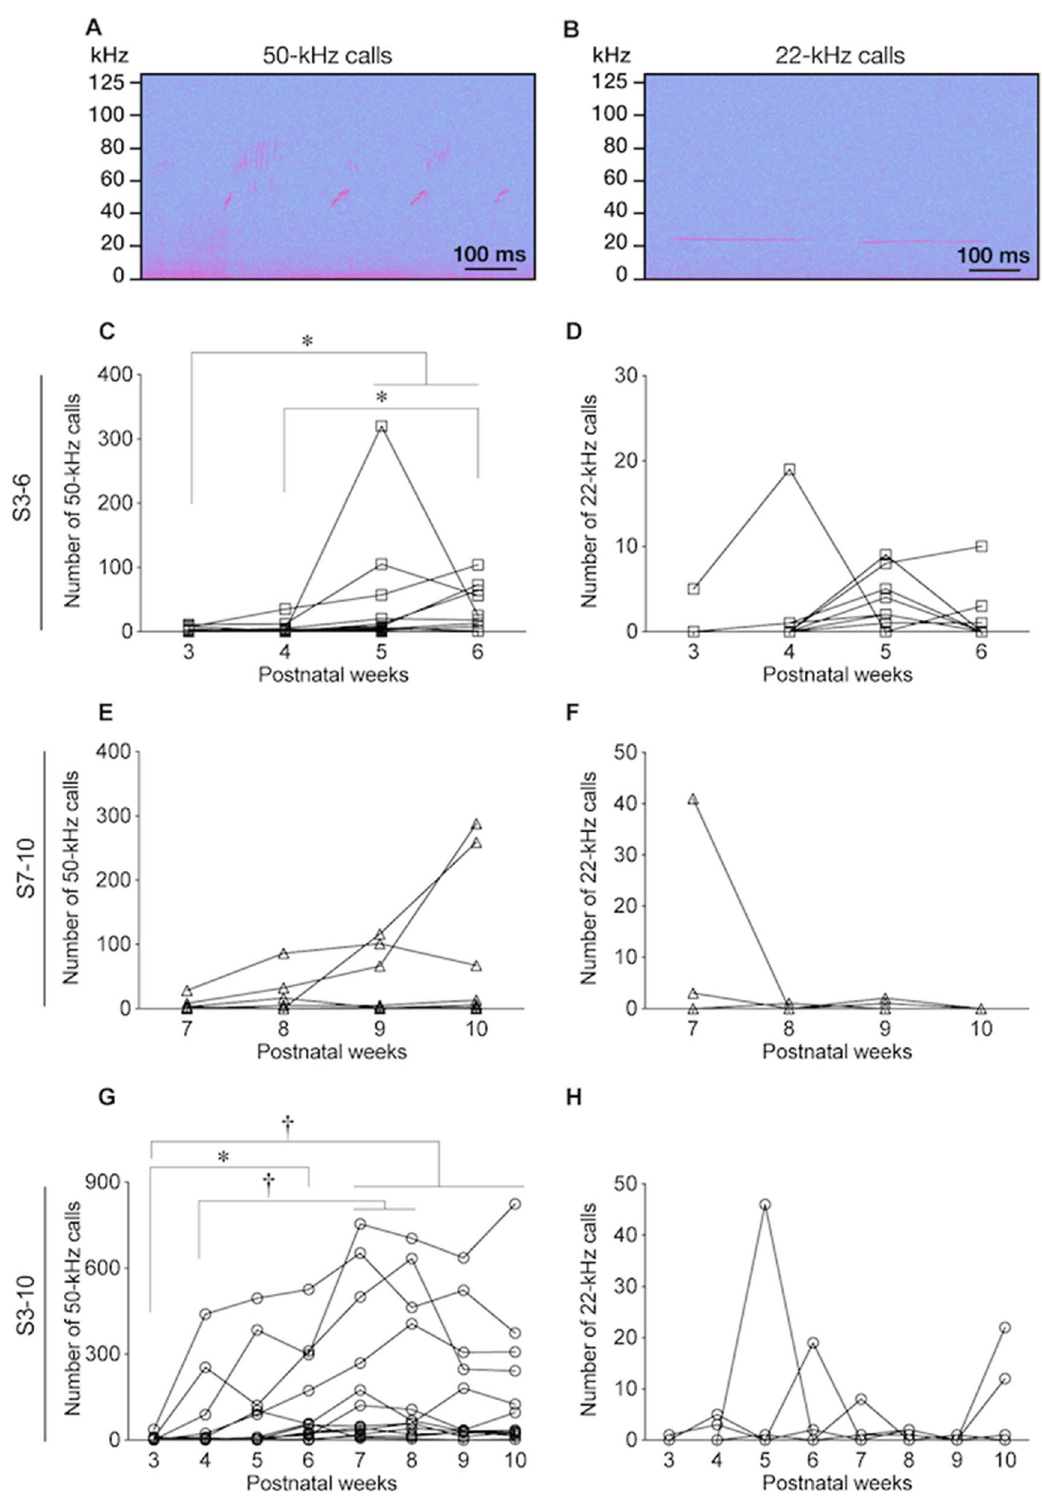
Figure 2. Ultrasonic vocalizations (USVs) during stroking stimuli. ( A , B ) Examples of spectrograms of 50-kHz calls ( A ) and 22-kHz calls ( B ). ( C – H ) Time courses of the numbers of vocalizations during stroking in the S3-6 group ( C , 50-kHz; D, 22-kHz), S7-10 group ( E , 50-kHz; F, 22-kHz), and S3-10 group ( G , 50-kHz; H, 22-kHz). In the S3-6 group, the numbers of 50-kHz calls at the ages of 5 and 6 were significantly larger than the number of 50-kHz calls at the age of 3 weeks. In addition, the number of 50-kHz calls at the age of 6 weeks was significantly larger than that at the age of 4 weeks. In the S7-10 group, the number of 50-kHz calls did not significantly change. In the S3-10 group, the numbers of 50-kHz calls at 6, 7, 8, 9, and 10 weeks of age were significantly increased compared to the number at the age of 3 weeks. The numbers of 50-kHz calls at 7 and 8 weeks of age were significantly larger than the number at 4 weeks of age. The numbers of 22-kHz calls during stroking did not significantly change in any of the three groups. †, P < 0.01; *, P < 0.05, post- hoc Holm’s